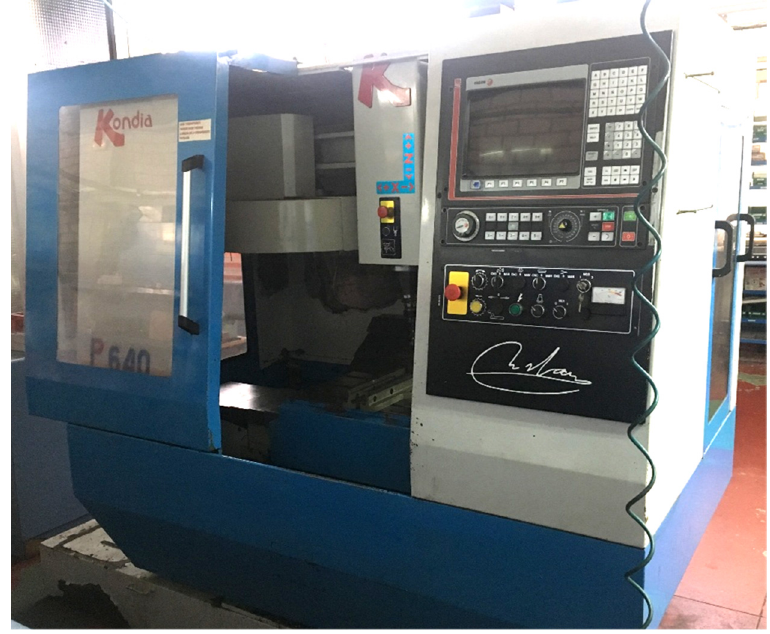
7 of 16 Figure 6. The third measurement scenario scheme. F rij —Force in the “r” direction, in the “i” position, with the load “j”. F ri1 —Force applied in the first cycle, demonstrated as the first load value. 3. Experimental Comparison of Static Stiffness Measurement Methods 3.1. Materials and Methods For experimental static stiffness measurement, the CNC Vertical Milling Machine (Kondia, Elgoibar, Spain), model “B 640” was used as a production machine with three fully controlled axes of the following parameters: 